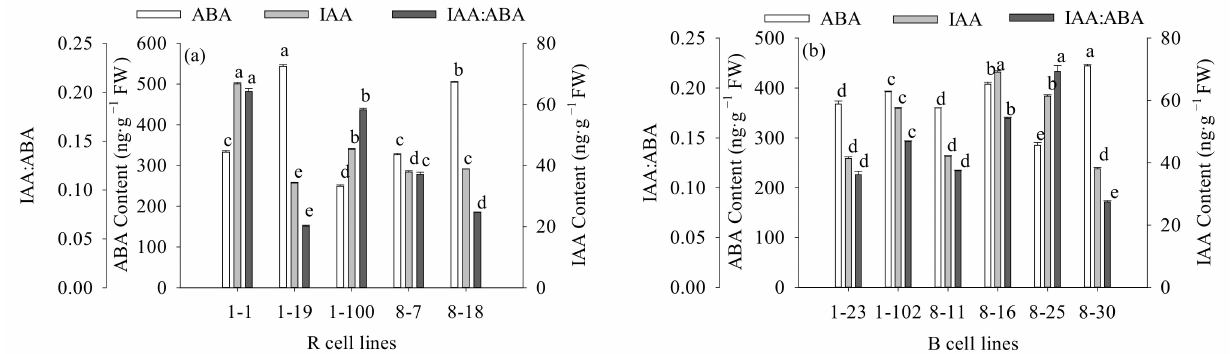
Figure 11. Differences in ABA and IAA contents between different cell lines of P. koraiensis . ( a ) R cell lines; ( b ) B cell lines. Different letters above the columns indicate significant differences at the p < 0.05